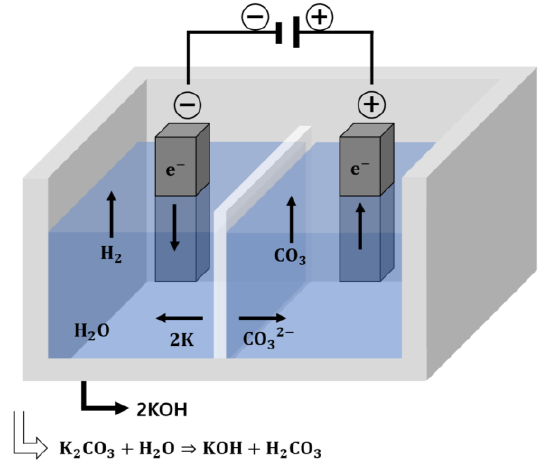
Figure 1. Electrolysis scheme of potassium carbonate.